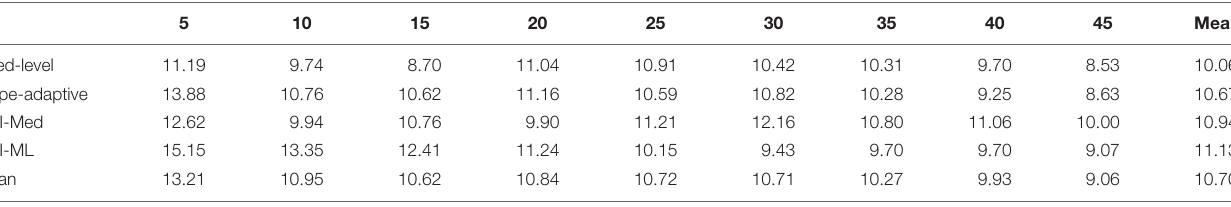
TABLE 3 | Standard deviations of sound pressure level (SPL) for each categorical unit (CU) for participants with hearing loss for each of the four CLS procedures at 1